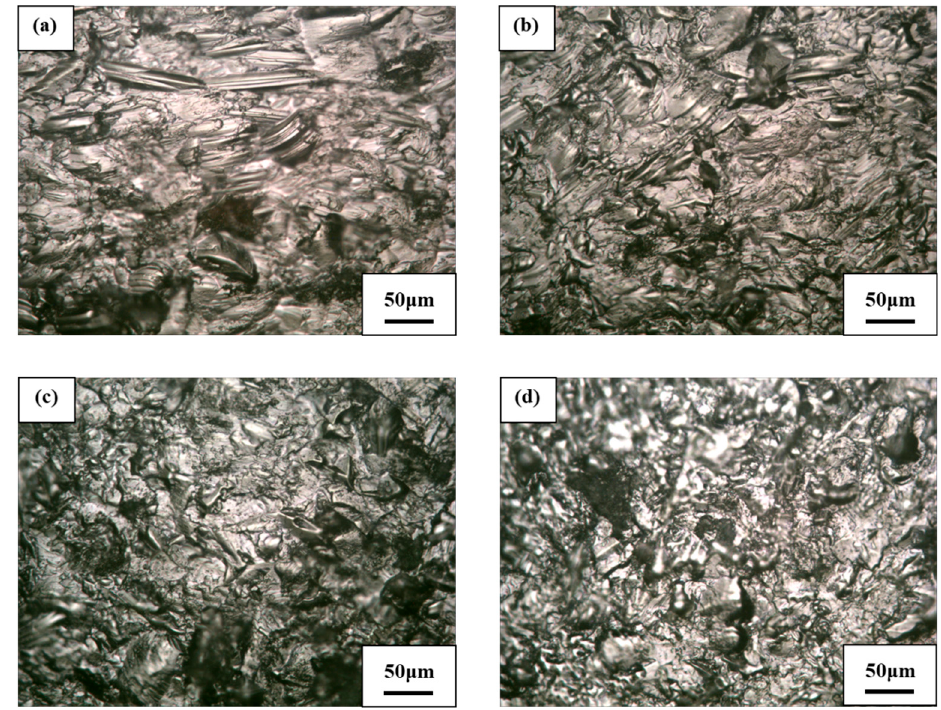
Figure 13. Optical microscopy morphologies of the SLMed Ti-6Al-4V alloy due to slurry erosion in pure water at impact angles of ( a ) 30 ◦ , ( b ) 45 ◦ , ( c ) 60 ◦ , and ( d ) 90 ◦ .